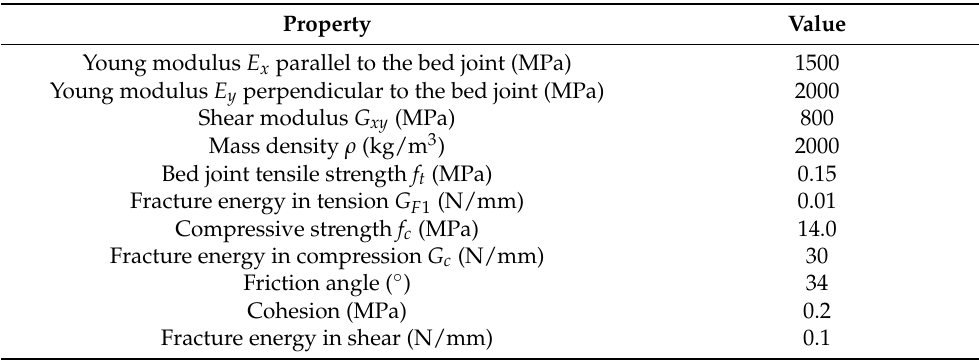
Table 1. Properties of the shell elements simulating masonry walls in buildings B1 and B2. Reprinted from Reference